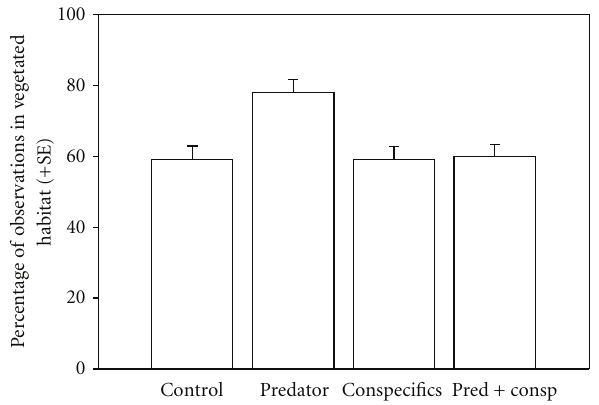
Figure 2: Preference of juvenile sticklebacks for the vegetated habi- tat in the absence and presence of a predator and four conspecifics. N = 28 for each